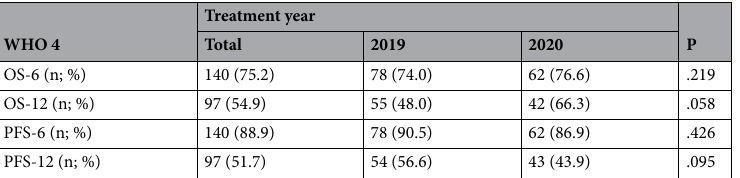
Table 3. Overall survival and progression-free survival at 6 and 12 months compared between the 2019 and 2020 cohorts of Patients with WHO Grade 4 gliomas according to Kaplan–Meier estimation. OS—overall survival, PFS—progression-free survival, n—number.